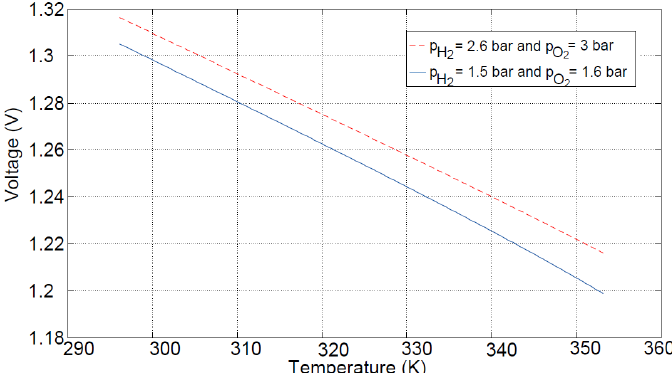
Figure 4. Thermodynamic potential as a function of temperature for two different pairs of reactant